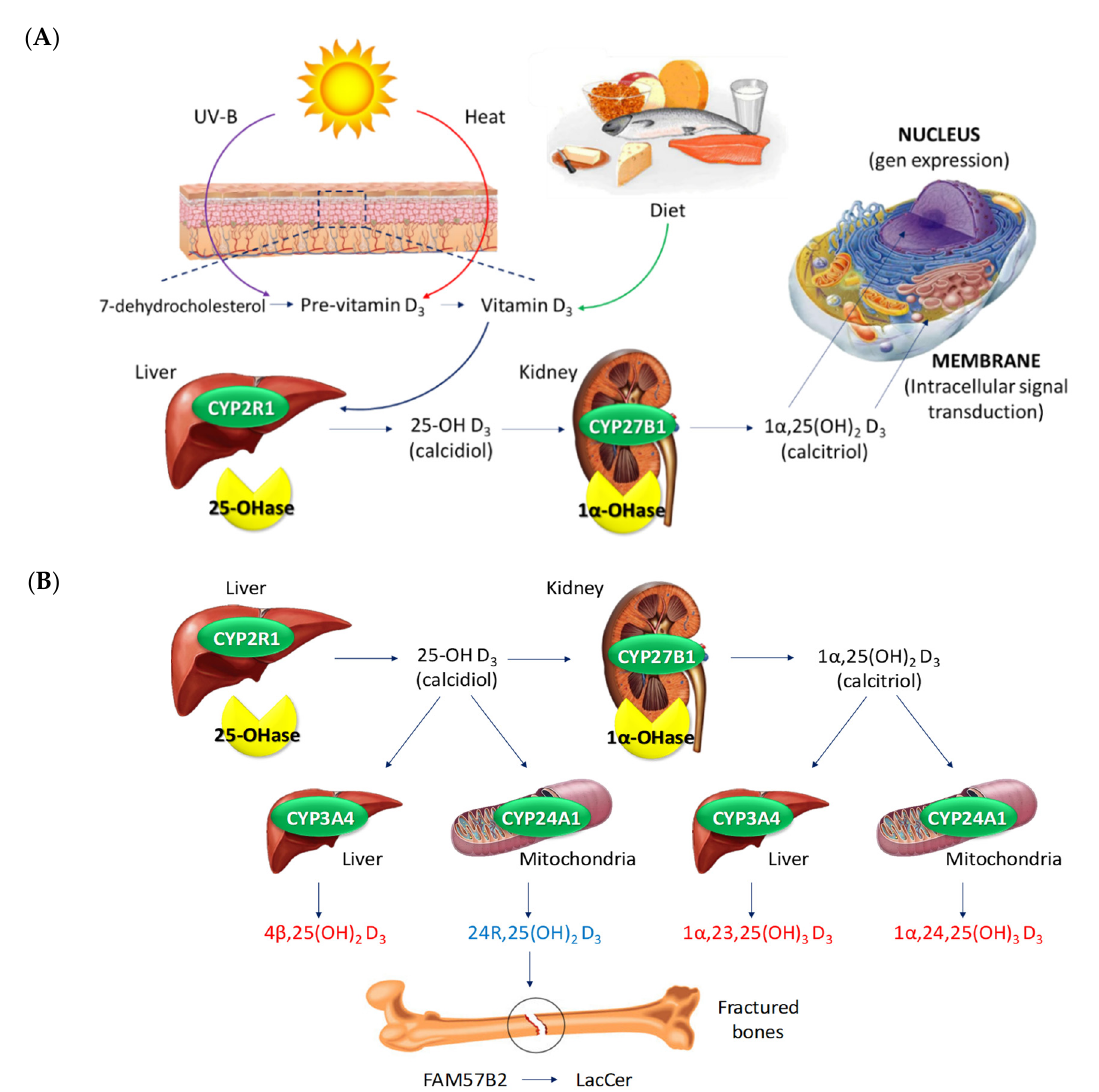
Figure 3. The physiological pathway of vitamin D synthesis and activation. ( A ) Ultraviolet radiation promotes the conversion of 7-dehydrocholesterol to pre–vitamin D 3 , which isomerizes to vitamin D 3 (also called cholecalciferol) in the skin, due to sun heat. Diet supplements directly provide Vitamin D 3 , also called ergocalciferol. In the liver, a 25- hydroxylation by CYP2R1 is carried out, thus leading to the formation of 25-hydroxyvitamin D 3 . In the kidney, CYP27B1 further hydroxylates 25-hydroxyvitamin D 3 at the 1- α position, resulting in the formation of the active hormone 1 α ,25- dihydroxyvitamin D 3 . The active form of vitamin D then enters into the cell via diffusion or endocytic receptor for transcription. Inside the cell, vitamin D binds to both vitamin D receptors at the nucleus and cell membrane. In the nucleus, both active forms of vitamin D and its receptor form a regulatory complex that finally leads to the beginning of the transcription process. In the cell membrane, binding to vitamin D receptors lead to several intracellular signal transductions. ( B ) An alternative pathway has been described. In this case, 25-hydroxyvitamin D 3 and 1 α ,25-dihydroxyvitamin D 3 metabolites are hydroxylated by other two cytochromes: on the one hand, a dominant gain-of-function mutation in CYP3A4, mainly located in the liver, leads to acceleration in vitamin D inactivation; on the other hand, hydroxylation by CYP24A1, mainly located in the mitochondria, gives rise to the formation of an active metabolite, 24R,25(OH) 2 D 3 . This molecule has been described to bind to FAM57B2 in fractured bones. This leads to the production of lactosylceramide (LacCer), which is essential for the callus formation and fracture healing.